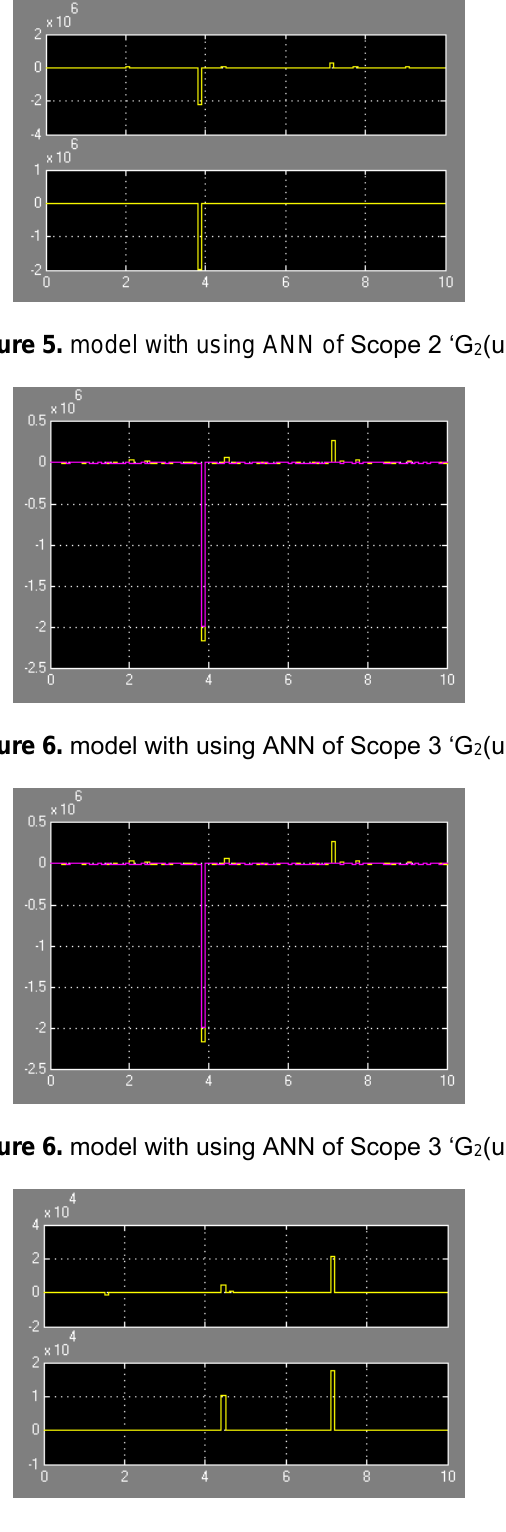
Figure 7. model with using ANN of Scope 2 ‘G 3 (u)’